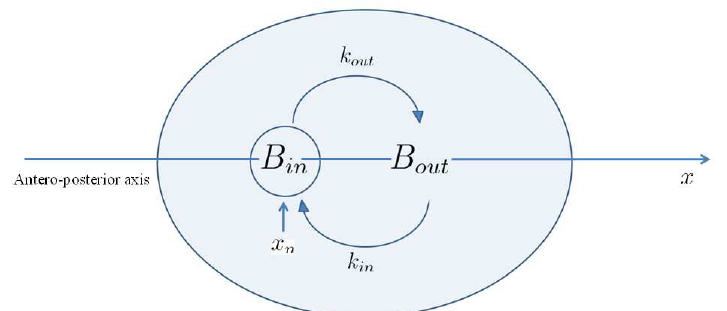
Figure 12: Bicoid exists in two states: freely diffusing B out , and immobile/nuclear B in . The tran- sitions between the two states are described by first order processes [7, 18]. The forward nuclear trapping rate constant is k i n , and the reverse process rate constant is k in